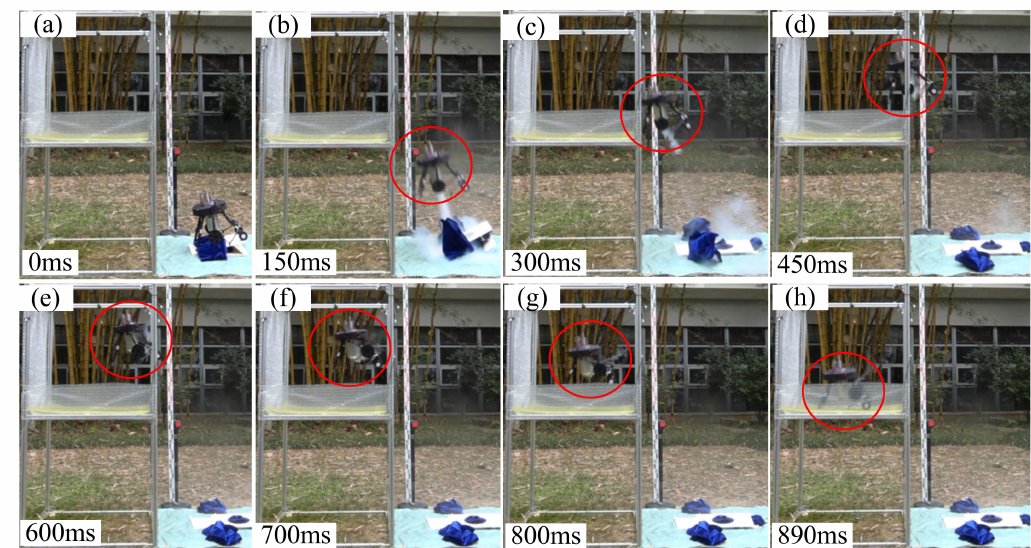
Figure 12. The time sequence of the jumping robot’s process of jumping onto the platform.